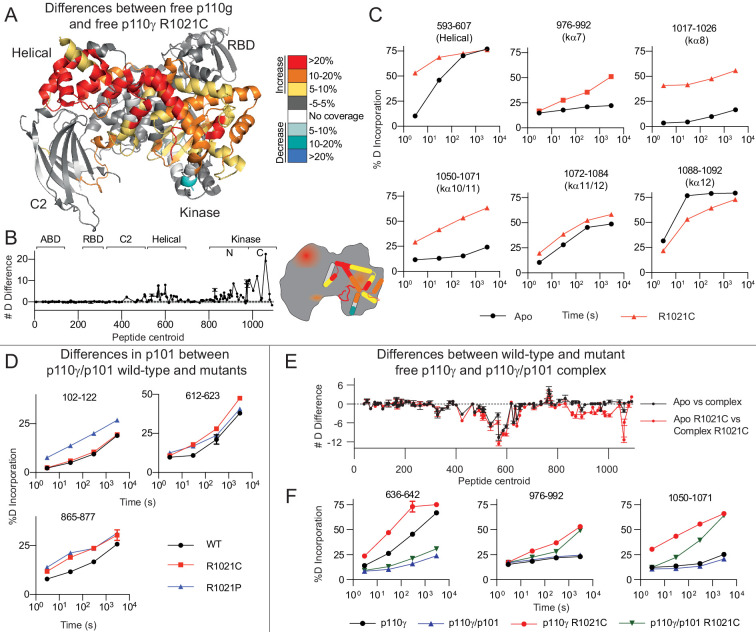
Differences in HDX for the R1021C mutation in free p110γ.(A) Peptides showing significant deuterium exchange differences (>5%,>0.4 kDa and p<0.01 in an unpaired two-tailed t-test) between p110γ wild-type and R1021C. Differences are coloured on a model of p110γ (PDB: 6AUD). (B) The number of deuteron difference for the R1021C mutant for all peptides analysed over the entire deuterium exchange time course for p110γ. (C) Selected p110γ peptides that showed significant decreases and increases in exchange are shown (>5%, >0.4 kDa and p<0.01 in an unpaired two-tailed t-test). (D) Selected p101 peptides that showed differences in exchange (>5%, >0.4 kDa and p<0.01 in an unpaired two-tailed t-test) are shown. (E) The number of deuteron difference between free p110γ and p110γ/p101 (black) and free p110γ R1021C and p110γ/p101 R1021C (red) for all peptides analysed over the entire deuterium time course for p110γ. The HDExaminer output data and the full list of all peptides and their deuterium incorporation is shown in the Figure 2—figure supplement 1—source data 1 file. (F) Selected p110γ peptides from experiments comparing wild-type p110γ and p110γ R1021C, and wild-type p110γ/p101 and p110γ/p101 R1021C. The full list of all peptides and their deuterium incorporation is shown in Source Data.
Figure 2—figure supplement 1—source data 1.Source data for HDX-MS comparing free p110g and free p110g R1021C.